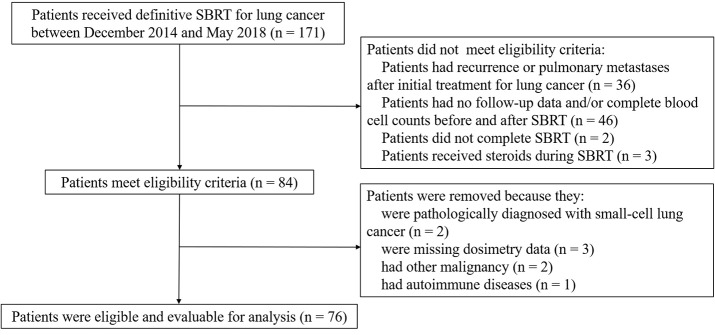
Identification of included and excluded patients with early-stage lung cancer receiving stereotactic body radiation therapy.